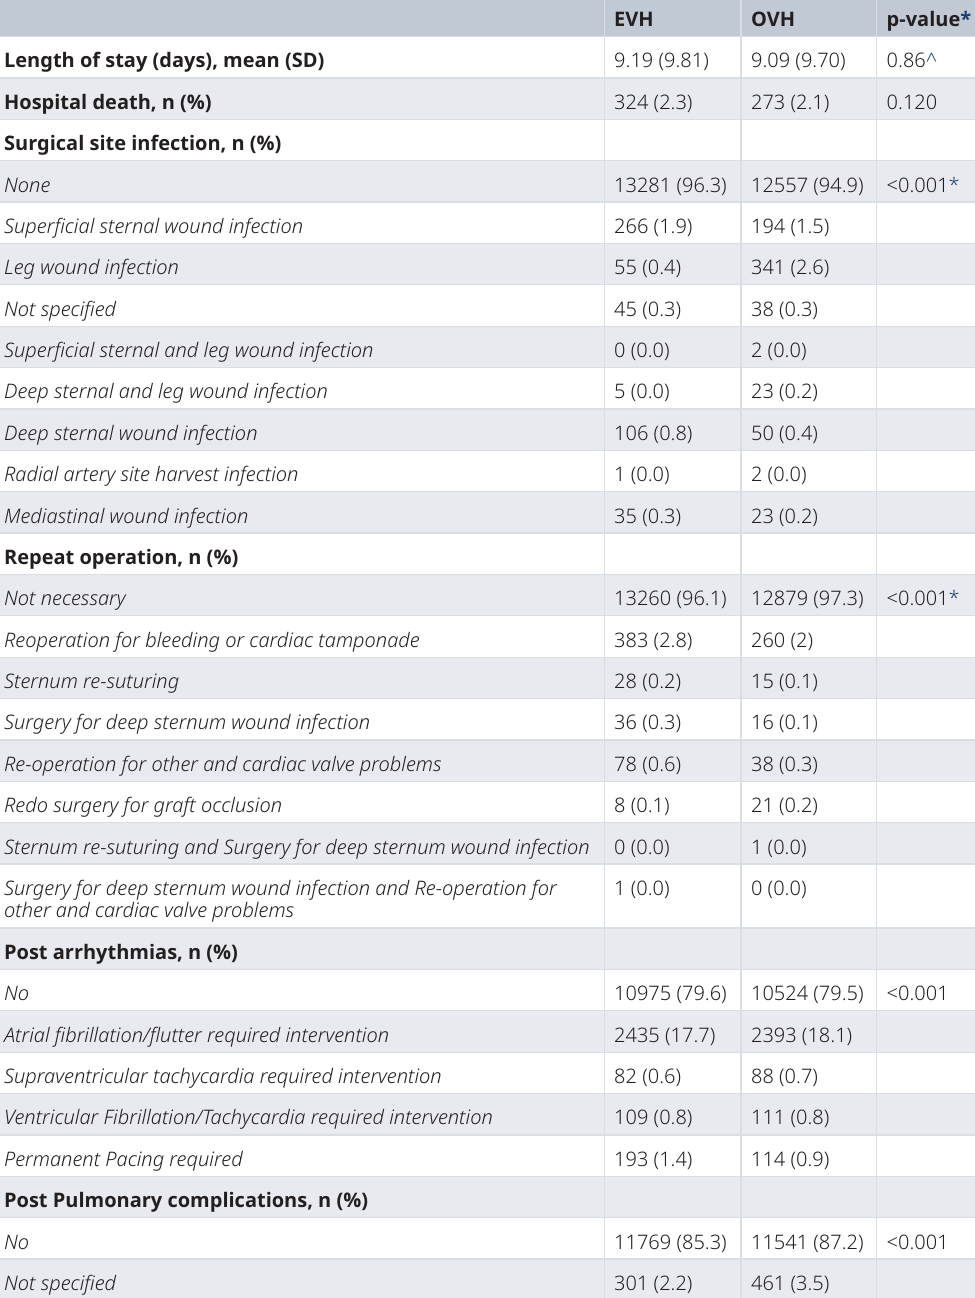
Table 3. Secondary